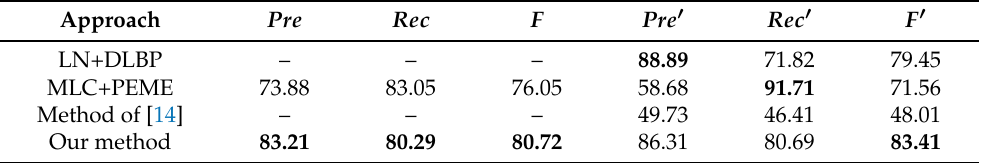
Table 2. Comparison between our method and the other methods for the Type-II RSDDs data set.